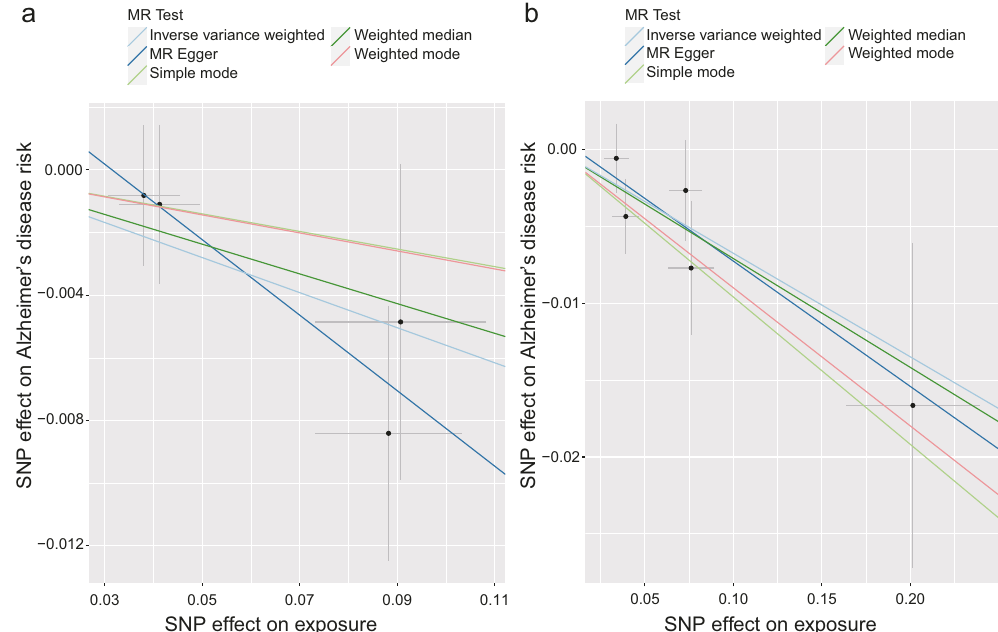
Fig. 3 Scatterplot of single-nucleotide polymorphism (SNP) associated with the cortical structure and Alzheimer ’ s disease. a Scatterplot of SNP associated with the cortical surface area of the temporal pole versus AD. b Scatterplot of SNP associated with the cortical thickness of the cuneus versus AD. AD Alzheimer ’ s disease, SNP single-nucleotide polymorphism. Vertical and horizontal lines around each SNP show 95% con fi dence